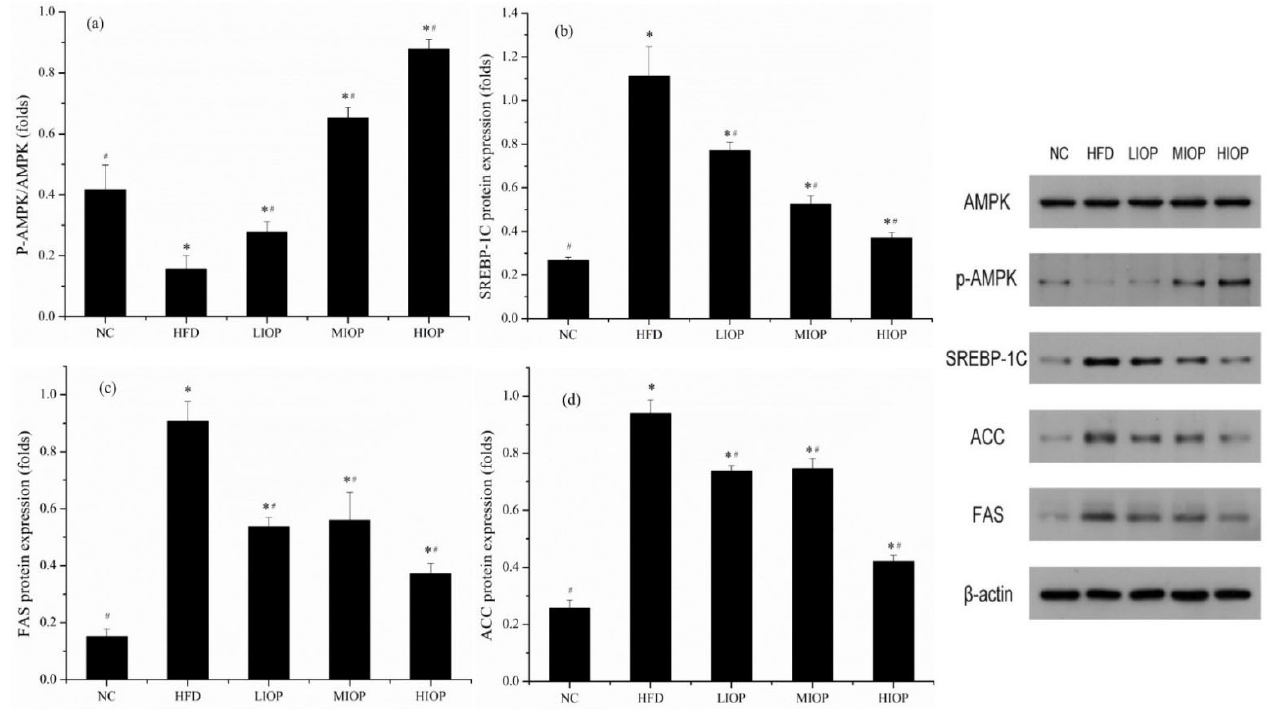
Figure 8. Effect of IOP on protein expression of mice livers. ( a ) P-AMPK/AMPK; ( b ) SREBP-1C, ( c ) FAS; ( d ) ACC. Each value represents the mean of eight mice, and error bars indicate the standard deviation (±SD). * p < 0.05, versus the NC group; # p < 0.05, versus the HFD group.